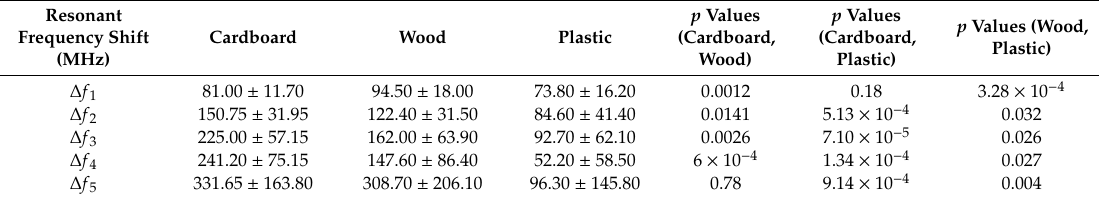
Table 4. Median ( ± median absolute deviation (MAD)) values of resonant frequency shift across all MUT samples, along with Wilcoxon rank sum test p values comparing each resonant frequency shift for each pair of MUTs.